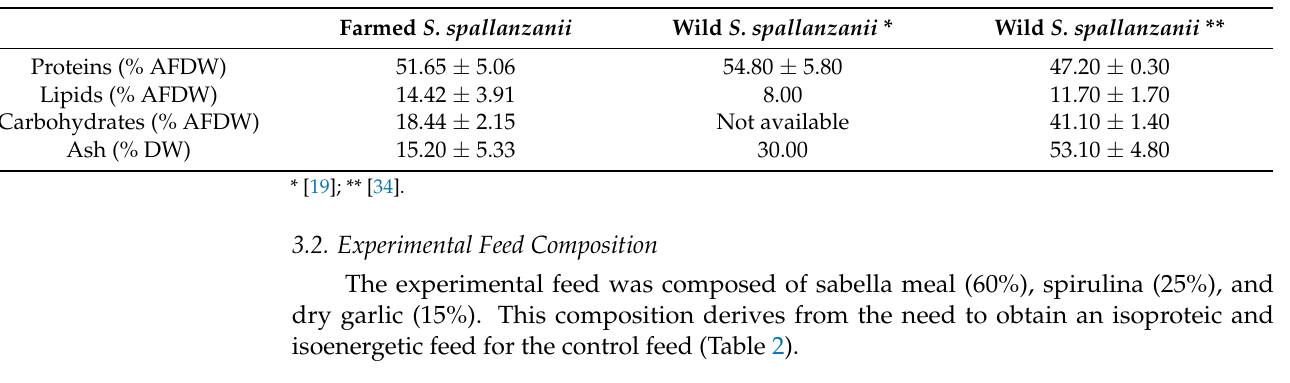
Table 2. Percentage composition and gross energy content (kJ/g) of experimental feed and its ingredients (sabella meal, spirulina, garlic) and control